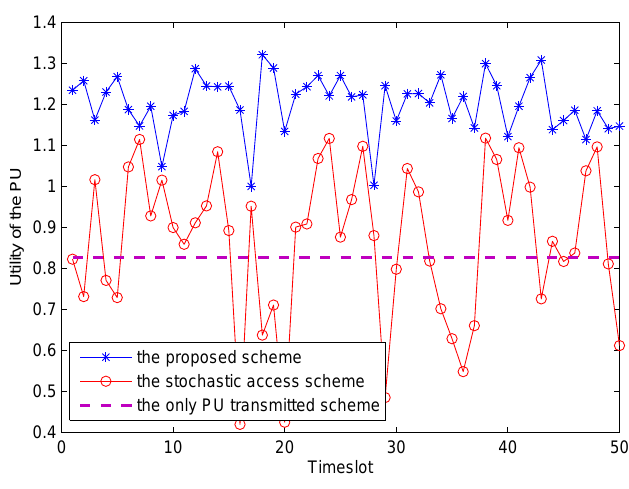
Figure 8. Utility of the PU in the different scheme.